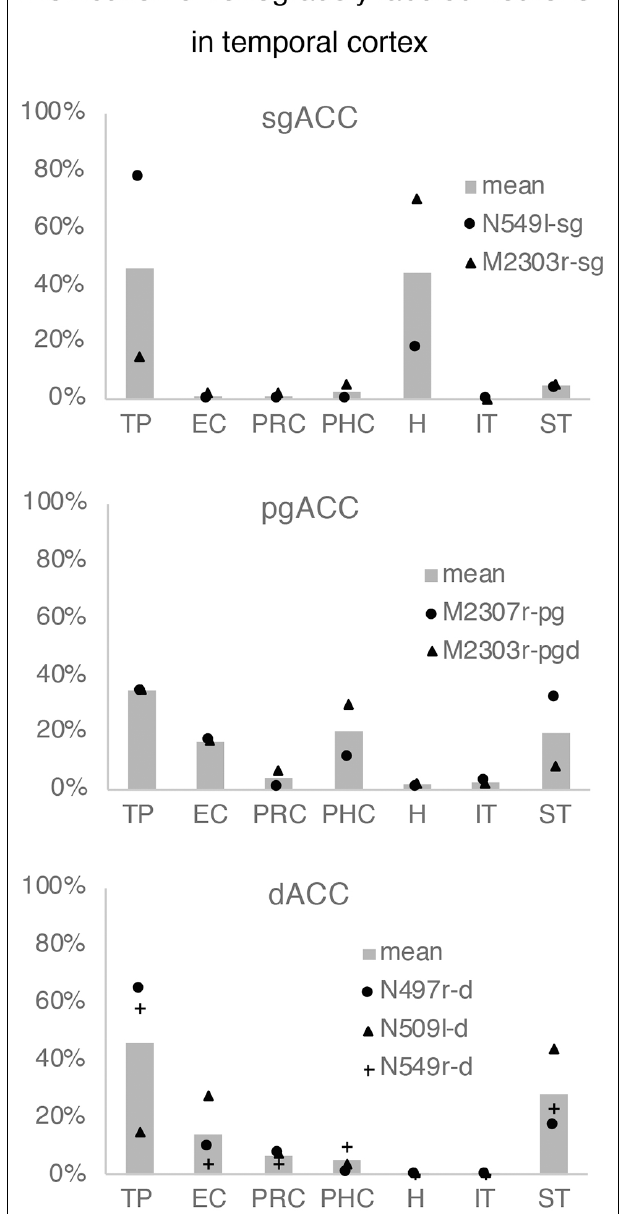
FIGURE 6 | The number of retrogradely labeled neurons in each area within the temporal cortex. The graphs show the results of the cases in which the tracer injection was well confined to the targeted area (see “Results” section). EC, entorhinal cortex; H, hippocampus; IT, inferior temporal cortex; PHC, parahippocampal cortex; PRC, perirhinal cortex; ST, superior temporal cortex; TP, temporal pole.